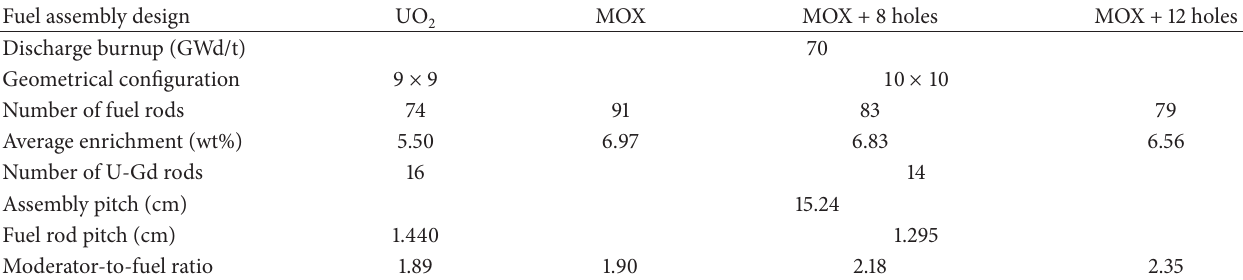
Index 𝑖 flags isotopes in the system, P : neutrons production rate and A : neutrons absorption rate. In the following,